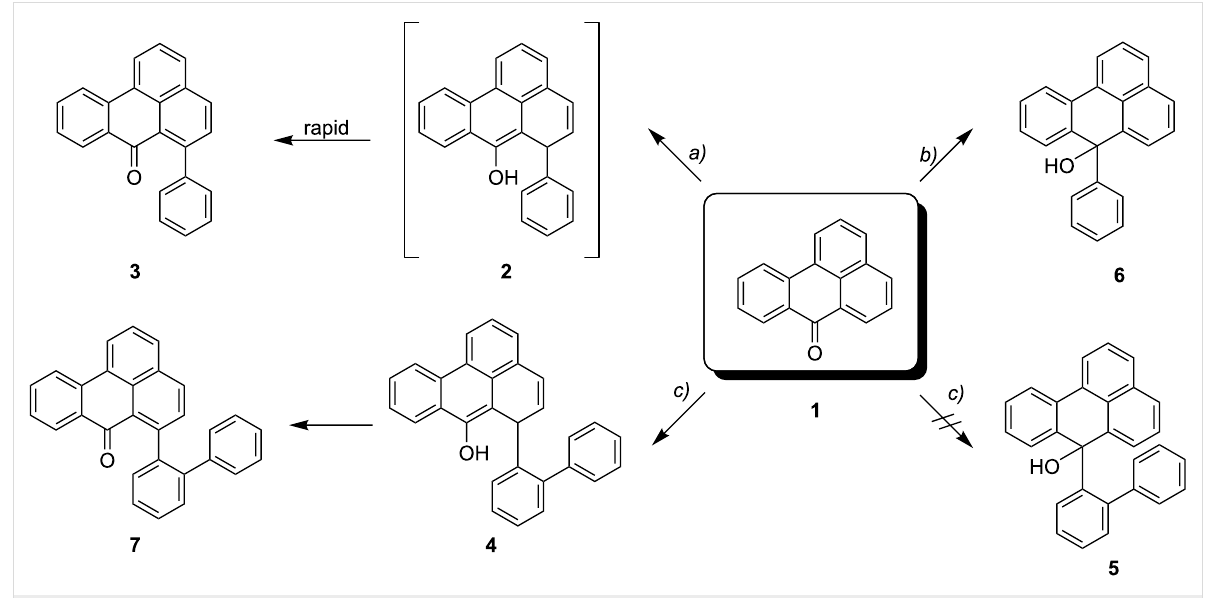
Here, we present the first isolable enol derived from a benzan- throne and the unexpected behaviour of this adduct under acidic